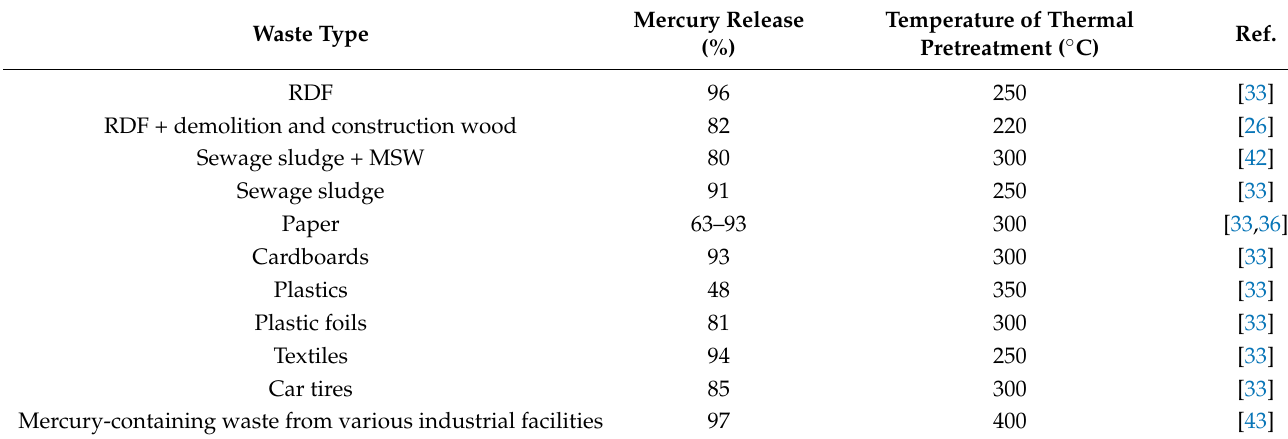
Table 4. Literature data on mercury release from solid waste in the thermal pretreatment